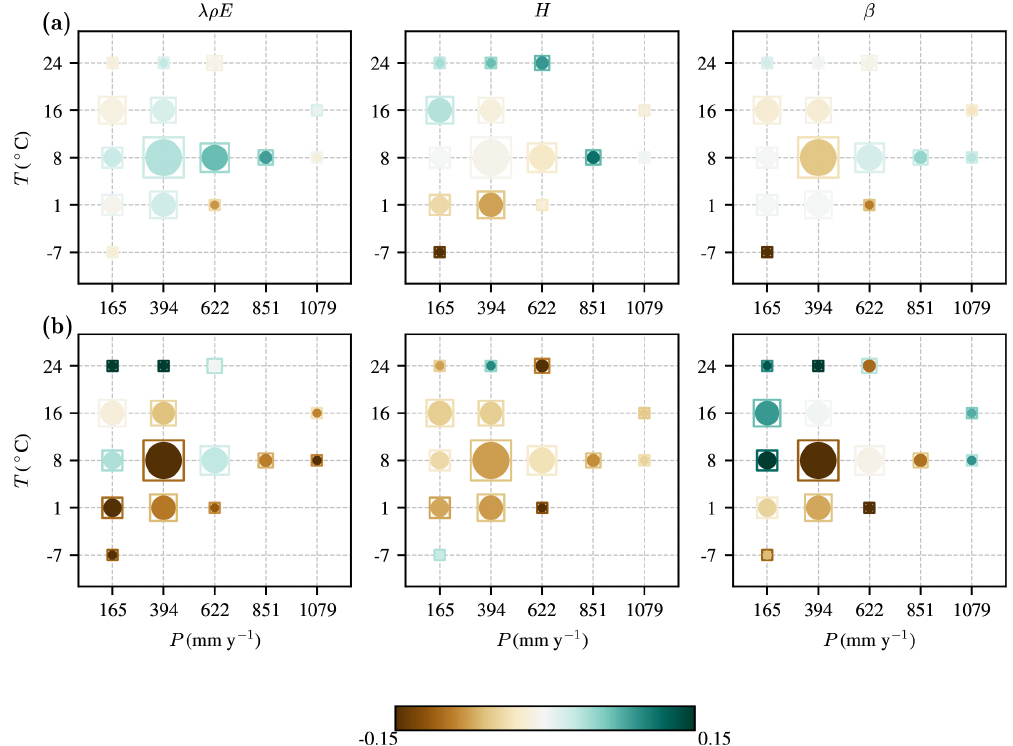
Figure 5. Difference between temporal validation statistics of the surface latent heat flux ( λρE ), surface sensible heat flux ( H ), and Bowen ratio ( β ) from GLEAM+ERA5, GLEAM+ERA-I, and ERA5 grouped as a function of precipitation rate ( P ) and near-surface air temperature ( T ) calculated at the in situ site. Panel (a) compares the statistics from GLEAM+ERA5 and GLEAM+ERA-I and (b) compares the statistics from GLEAM+ERA5 and ERA5. Statistics are calculated against in situ eddy-covariance measurements at daily resolution and then averaged across the sites within each group. Statistics include the MAD (anomaly in situ time series from 77 sites as reference) and R (anomaly in situ time series from 77 sites as reference). In panel (a) , circles show the R from GLEAM+ERA5 minus the one from GLEAM+ERA-I, while squares show the MAD from GLEAM+ERA-I minus the one from GLEAM+ERA5; hence, green colours represent better statistics for GLEAM+ERA5 compared to GLEAM+ERA-I. In panel (b) , statistics from GLEAM+ERA-I are replaced by ERA5; hence, green colours represent better statistics for GLEAM+ERA5 compared to ERA5. The size of the symbols relates to the number of in situ sites per group.